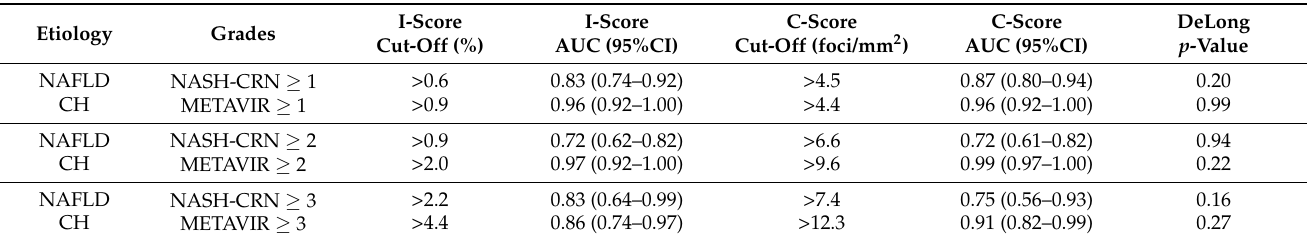
Table 4. Diagnostic accuracy of digital image analysis: raw performance parameters of I-score (%CD45+) and C-score (clusters proportion) for different etiologies of chronic liver disease stratified by histological grade. The DeLong p -value compares the AUCs of the software performance for specific grades of NASH-CRN and METAVIR scores.